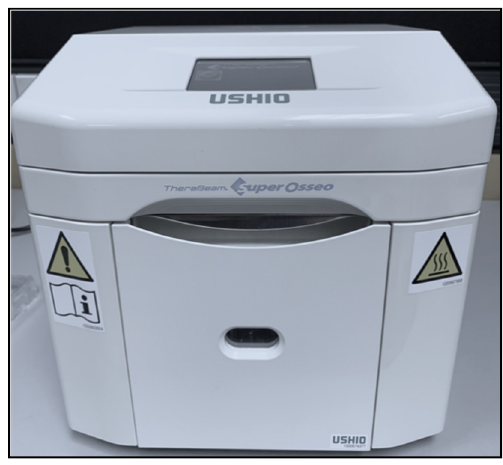
Figure 3. Therabeam ® SuperOsseo, (Ushio Inc., Tokyo, Japan).